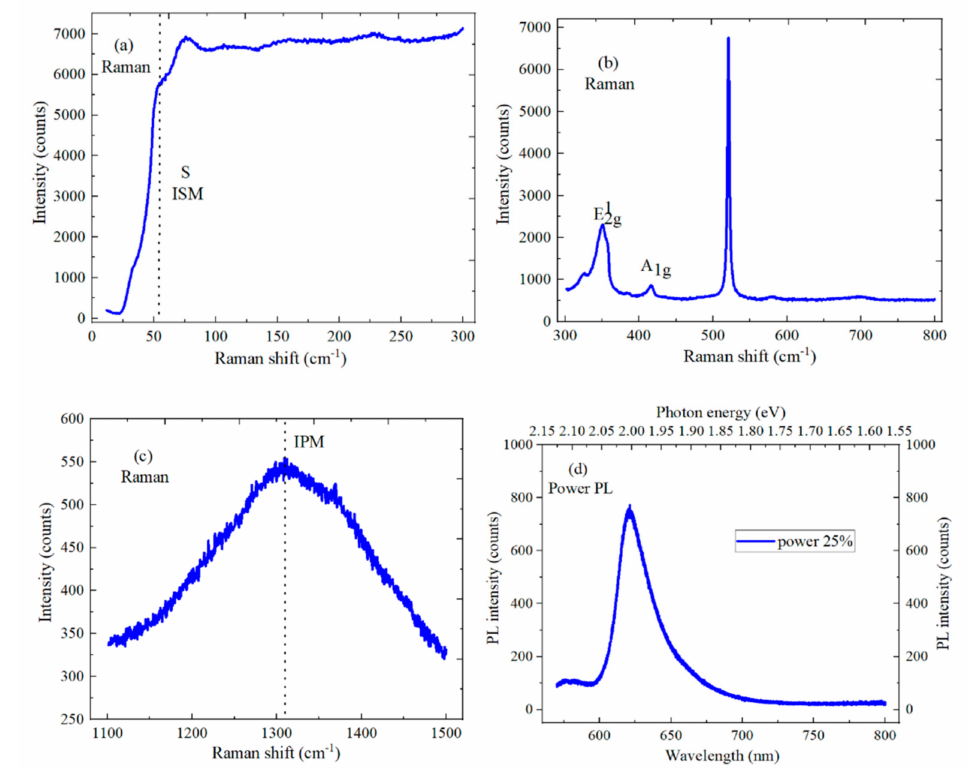
Figure 6. Spectral characteristics of WS 2 /h-BN heterostructure material. ( a ) ISM mode characteristic peak of h-BN material; ( b ) Raman spectrum of WS 2 material; ( c ) IPM mode characteristic peak of h-BN material; ( d ) Photoluminescence (PL) spectrum of WS 2 /h-BN heterostructure